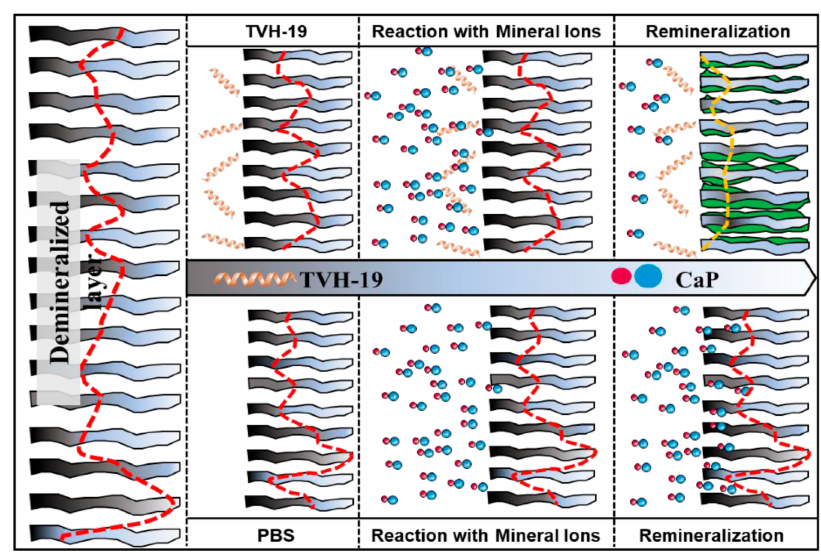
Figure 6. Patterns of TVH-19 promoting the closure of dentine tubules